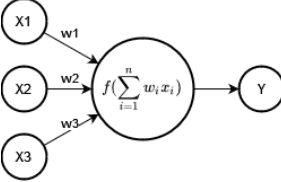
Figure 4. Schematic view of a neuron. Elements from the array returned by the previous layer are multiplied by a scalar (the parameters θ ) and then a non-linear activation function is applied.